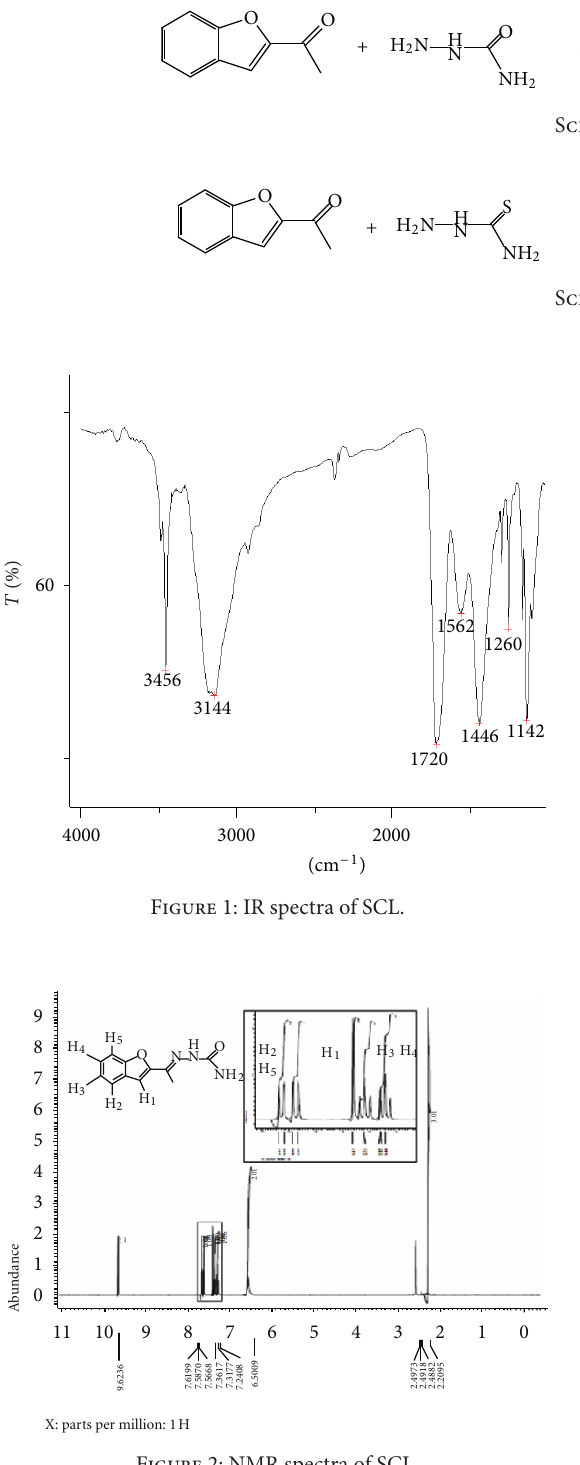
F 2: NMR spectra of SCL.